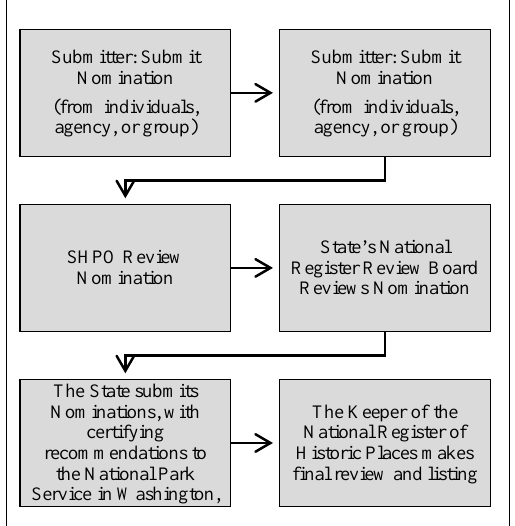
Figure 5. The National Register Listing